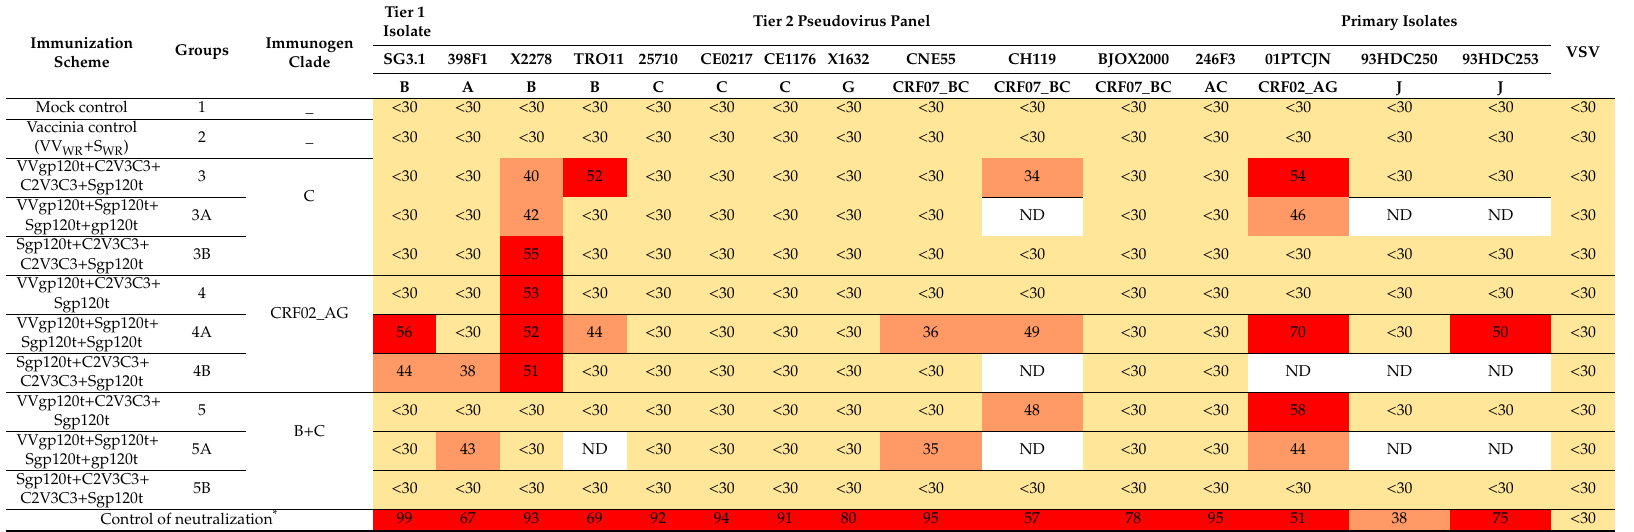
Table 5. Neutralizing activity in mice immunized in the main mice